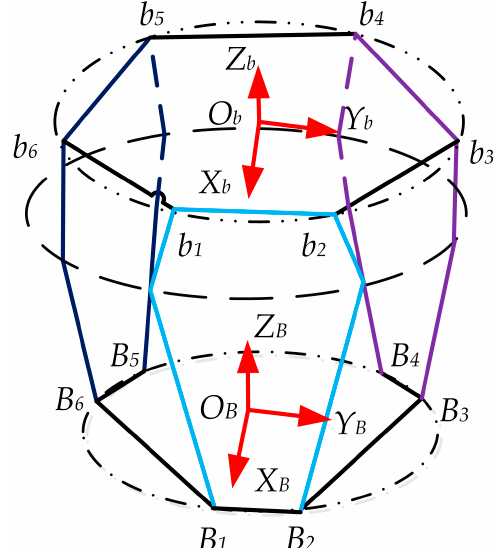
Figure 4. Diagram of fixed coordinate frame and moving coordinate frame of the sensor structure.